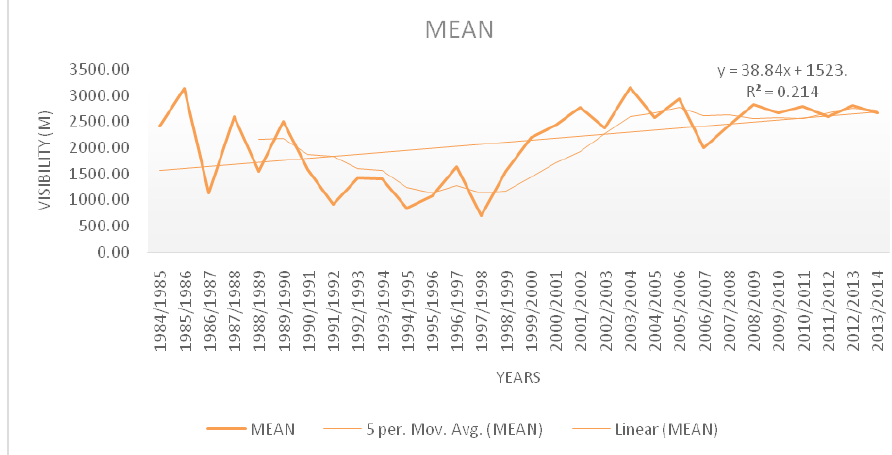
Figure 7: Seasonal mean distribution and trend of air visibility for Potiskum station (1984-2014).